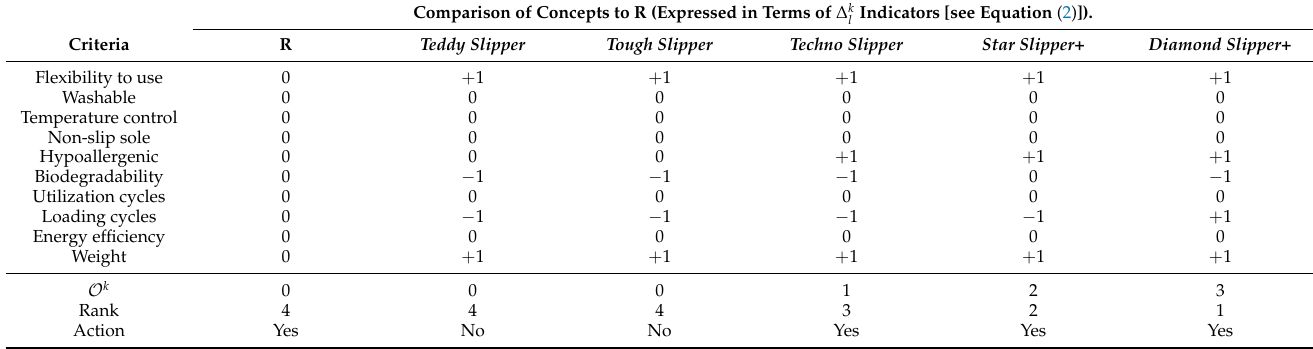
Table 17. Results of concept screening for new set of concepts.